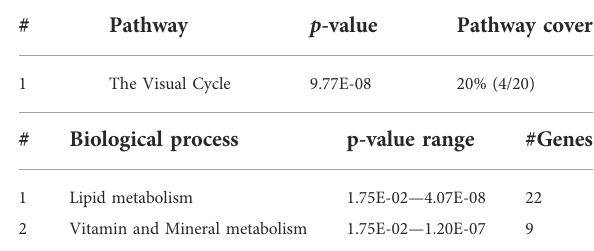
TABLE 4 IPA top enriched pathways and biological processes in gne KO versus gne WT at 5 dpf.